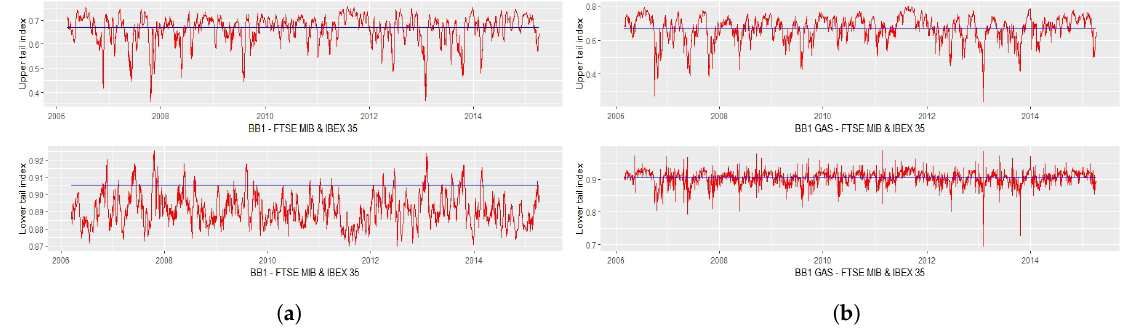
Figure 2. Upper and lower tail indices of FTSE MIB–IBEX 35; ( a ) BB1 copula with dynamic Equation (6); ( b ) BB1 copula with dynamic Equation